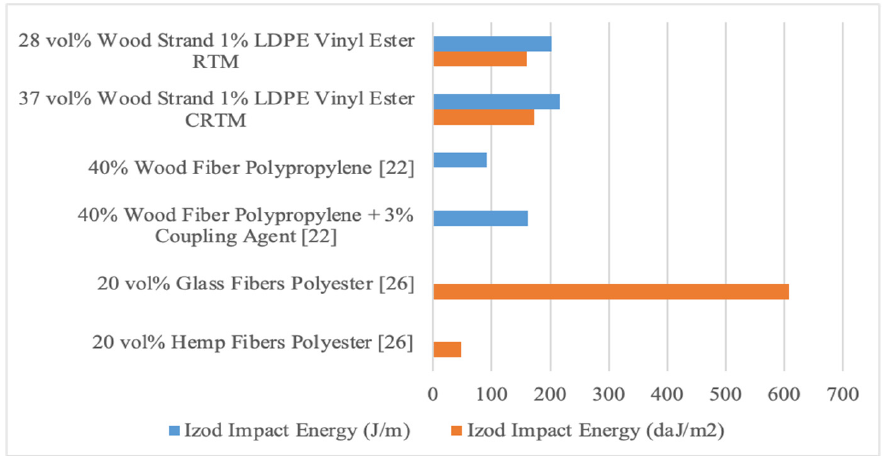
Figure 14. Izod impact properties of RTM and CRTM wood strand panels compared to other panels from published data ([22,26]).